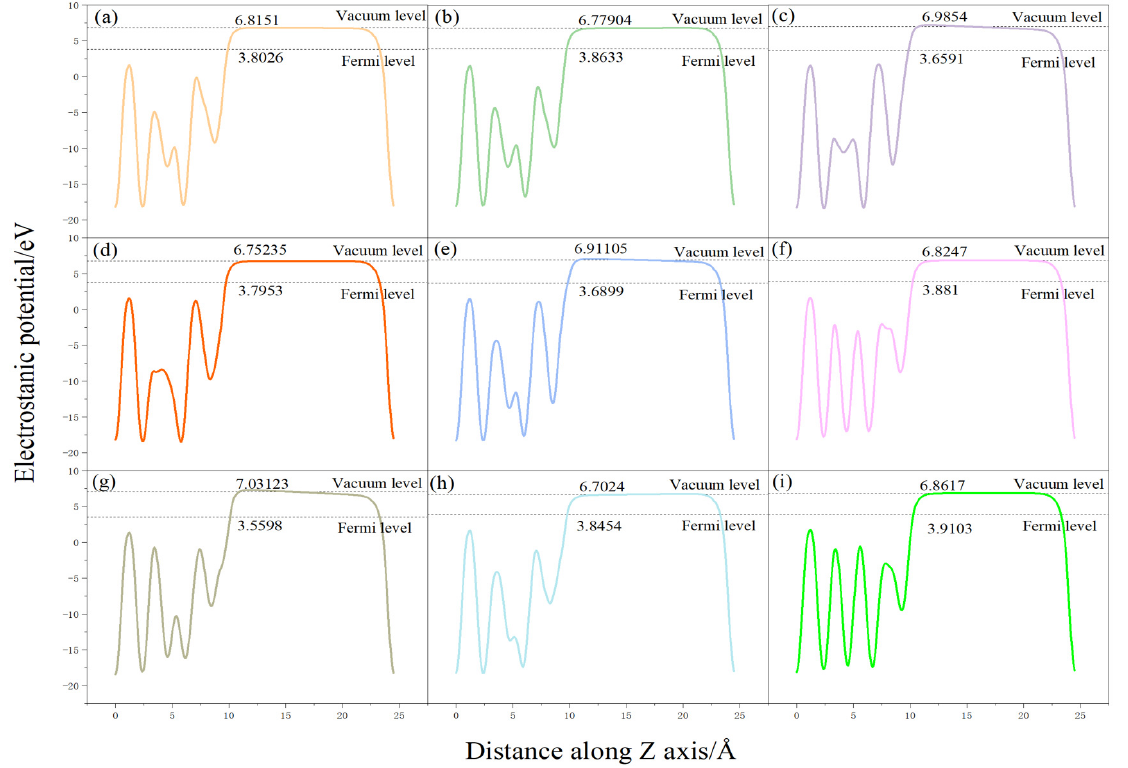
Figure 7. Variation of electrostatic potential along Z -axis for various configurations: ( a ) O-t-ver, ( b ) O-t-hor1, ( c ) O-t-hor2, ( d ) O-h-ver, ( e ) O-h-hor1, ( f ) O-h-hor2, ( g ) O-b-ver, ( h ) O-b-hor1, ( i ) O-b-hor2.